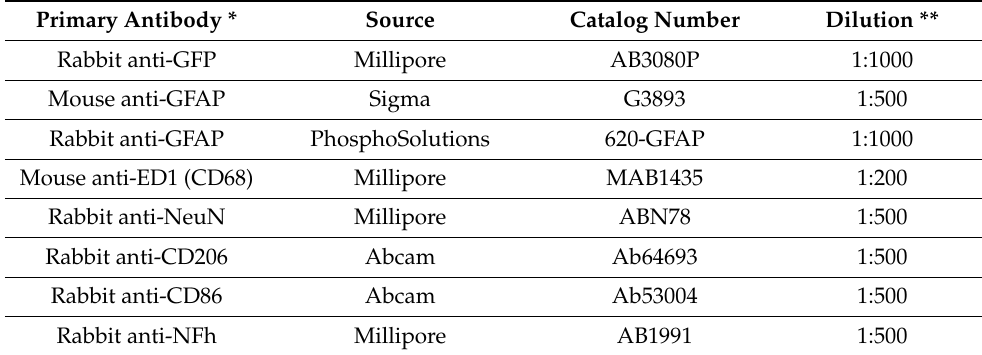
Table 1. Source, catalog number, and dilution of the used primary